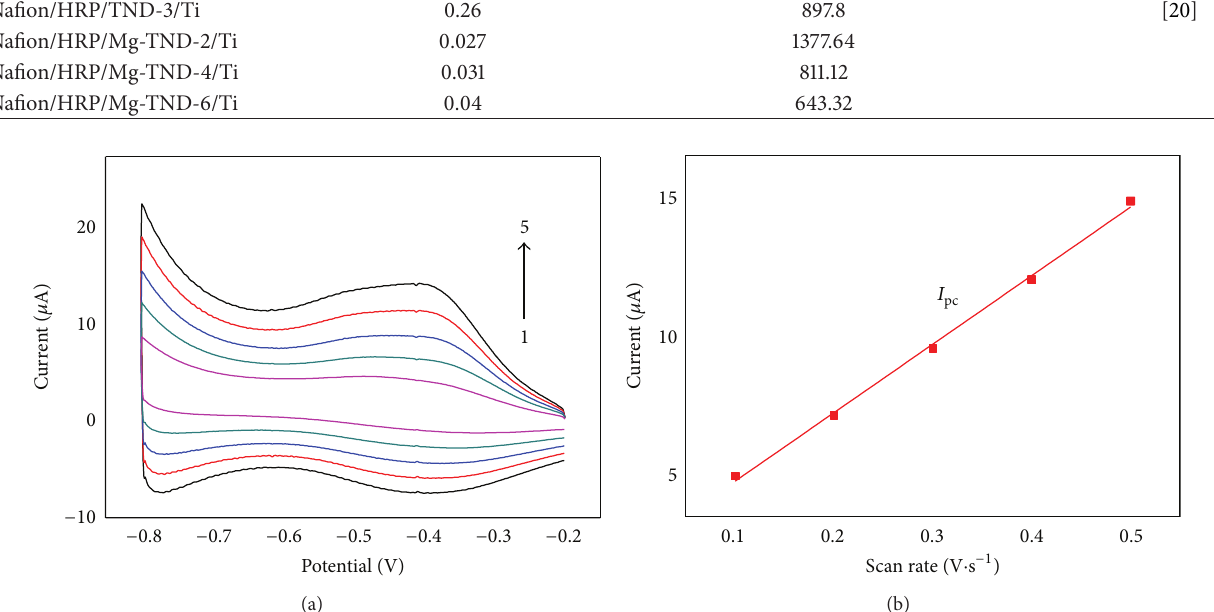
Figure 5: (a) Cyclic voltammetry of modified biosensor Nafion/HRP/Mg-TND-2 in PBS (0.1M, pH = 7.0) with various scan rates. (b) Plot reduction peaks current versus scan